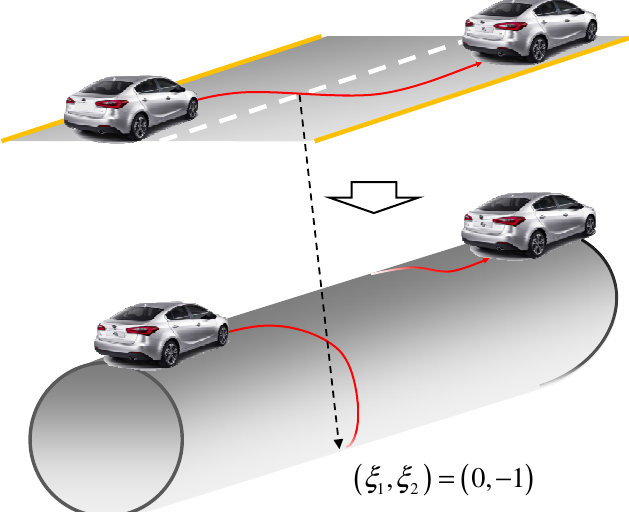
Figure 3. Lane change on the cylinder